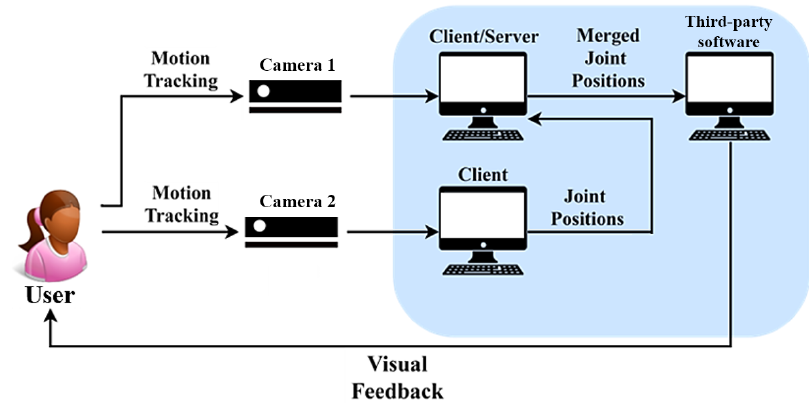
Figure 1. Configuration of the RGB-D system.